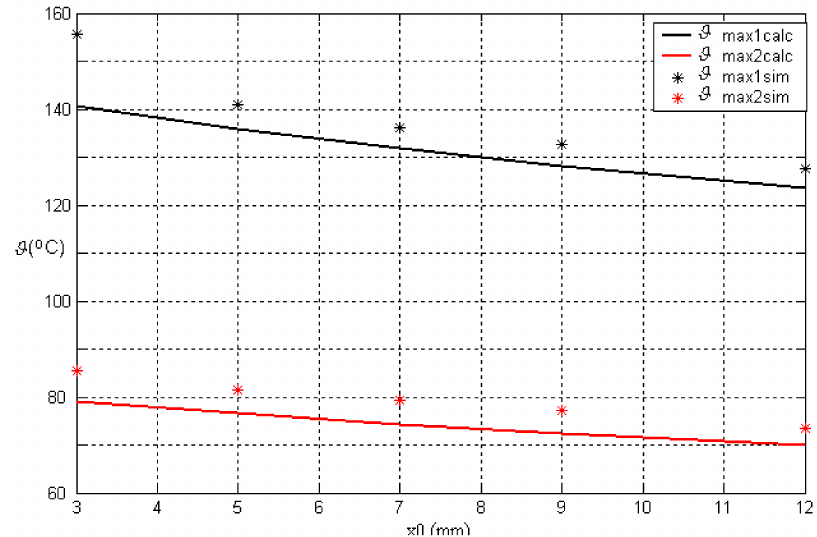
Figure 10. Maximum temperature rise variation for various distances between notches. Comparison